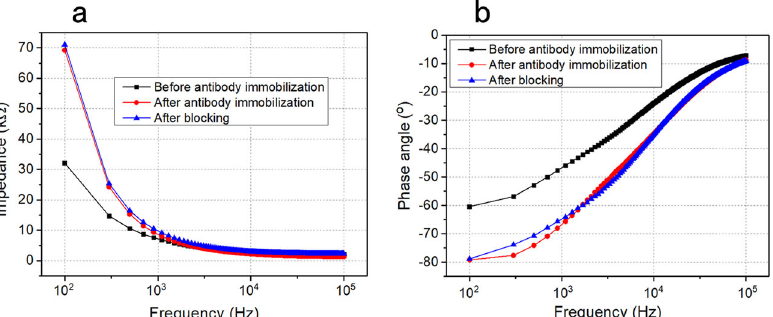
Fig. 2 Characterization for sensor ’ s functionalization by Bode plots. a Impedance and b phase angle from 10 2 to 10 5 Hz to describe the IDME surface modi fi